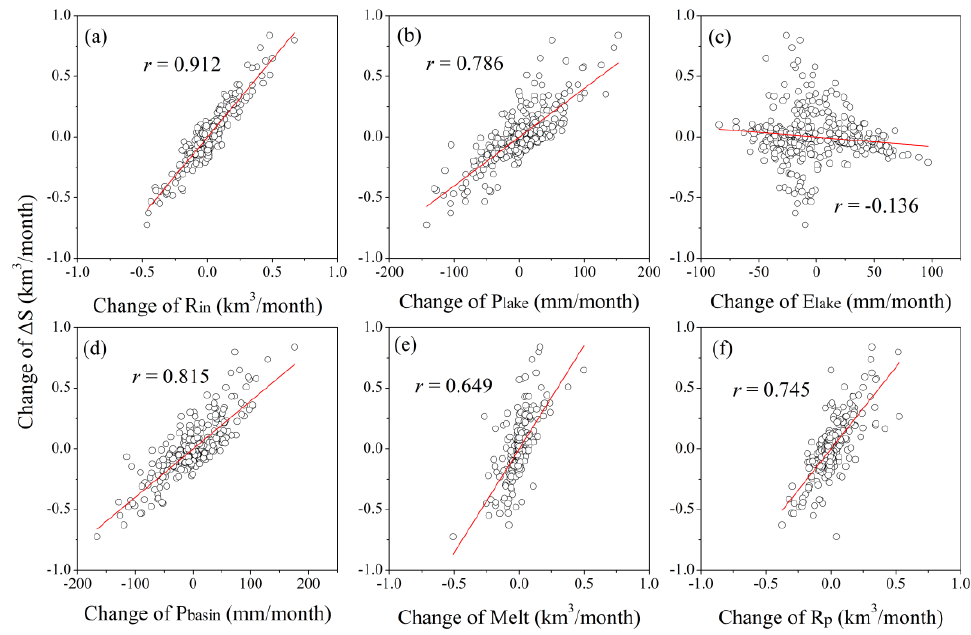
Figure 13. Comparison between monthly change of ∆ s and ( a ) total lake inflow, ( b ) lake surface precipitation, ( c ) lake surface evaporation, ( d ) basin average precipitation, ( e ) snow and glacier melt, ( f ) precipitation runoff from 1980 to 2016.